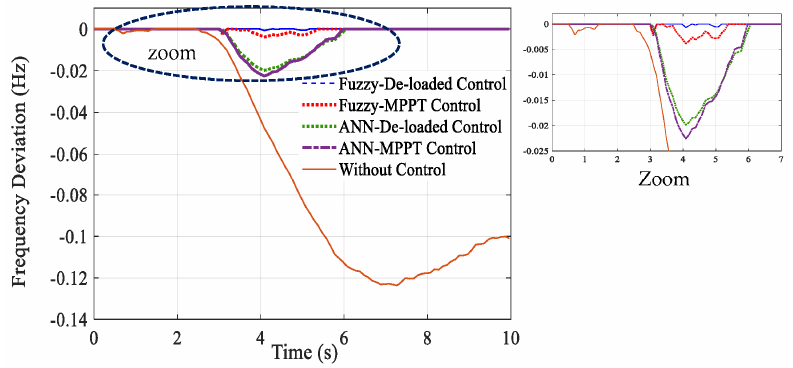
Figure 18. DT-FLC and MPPT frequency control variation.